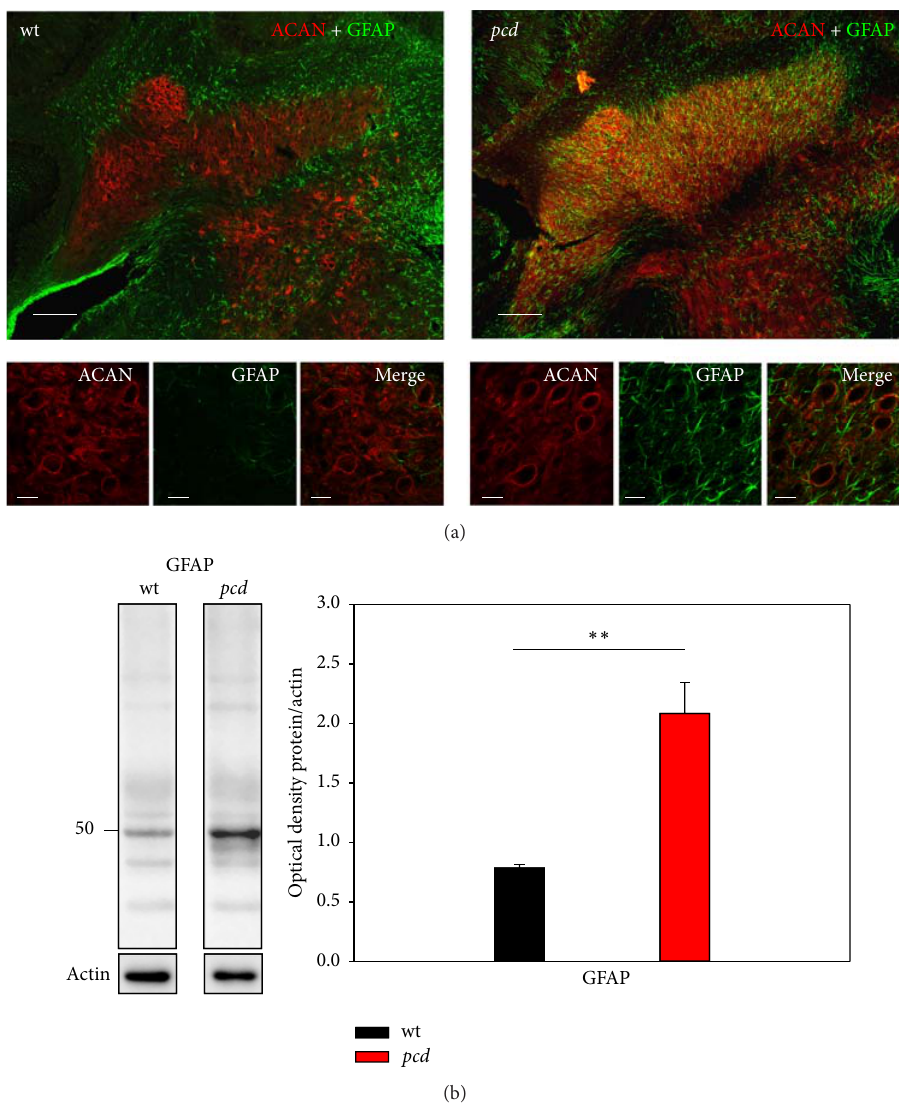
Figure 7: Reactive astrogliosis in the DCN of pcd mouse brain. (a) DCN of wt mouse brain is characterized by the virtual absence of reactive astrocytes. In pcd , the degeneration process is accompanied by a strong astrocytic activation; the DCN seem to be filled with astrocytes. Scale bar: overview 100 𝜇 m, detail 20 𝜇 m. (b) Western blot analyses confirm the immunocytochemical data. In pcd tissue, the GFAP protein level is more than 2-fold increased ( 𝑝 < 0.01 ). Data are given as mean ±